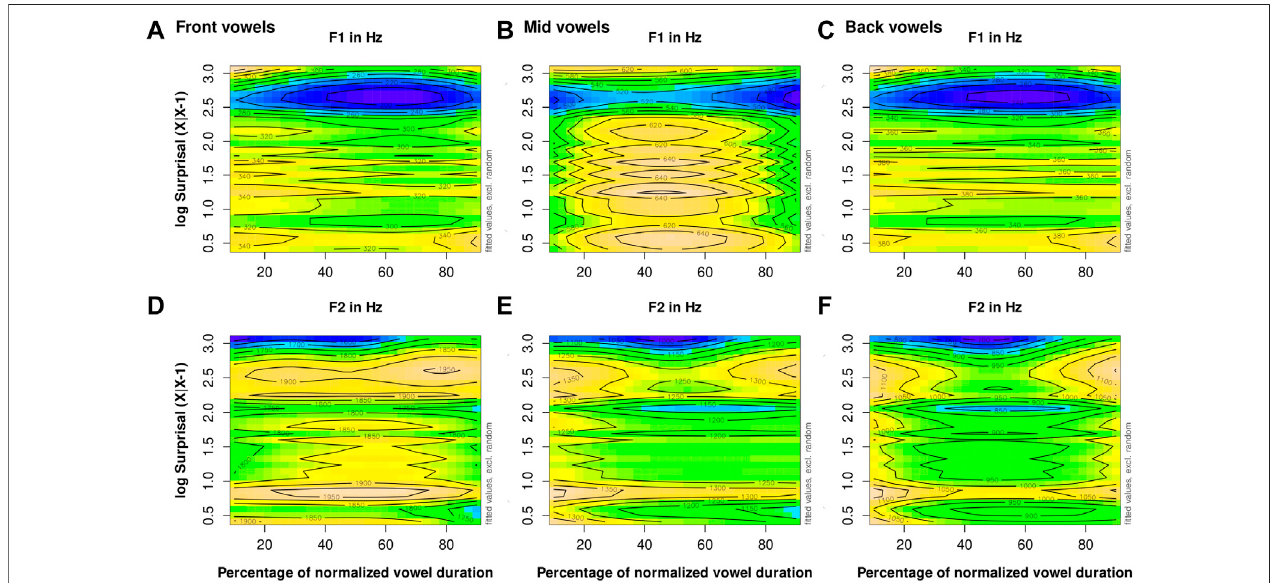
FIGURE 6 | Stressed vowels: heatmap of the interaction of biphone surprisal of the preceding context (log Surprisal (X | X-1)) and the measurement point on the trajectory of the fi rst formant (A) and the second formant (B) per the vowel categories front (C) , mid (D,E) , and back (F) .